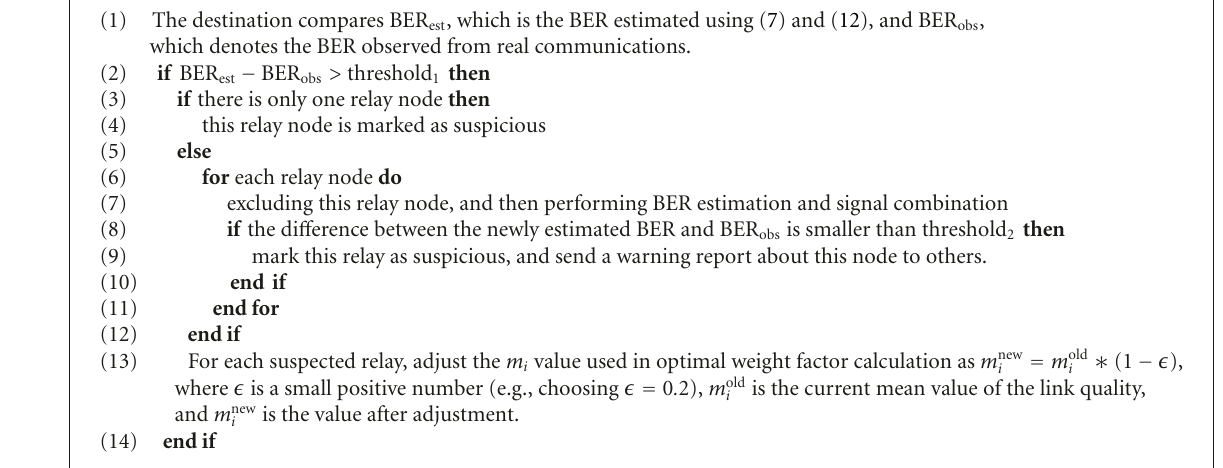
Algorithm 1: Defense against bad-mouthing attack.